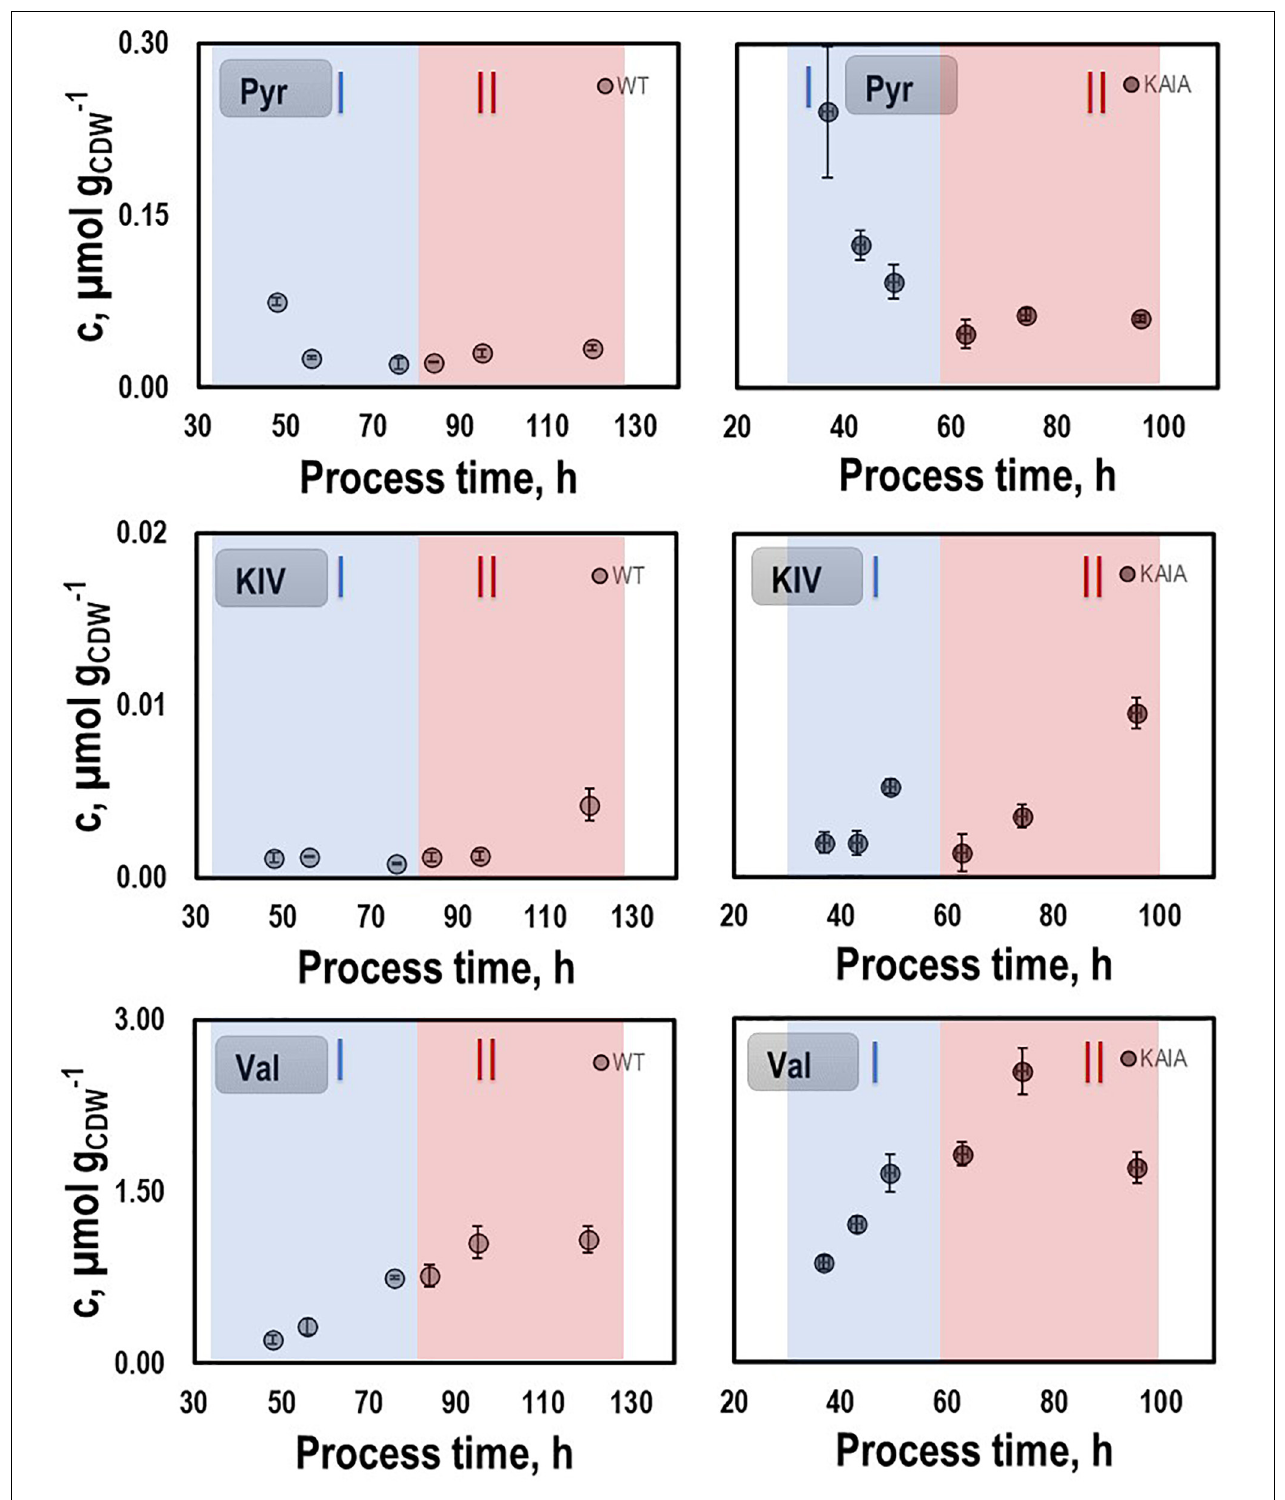
FIGURE 7 | Pyruvate (PYR), ketoisovalerate (KIV), and valine (VAL) pools in autotrophic batch cultivations of CLJU[WT, REF] and CLJU[KAIA] using syngas. Error bars are derived from technical replicates.